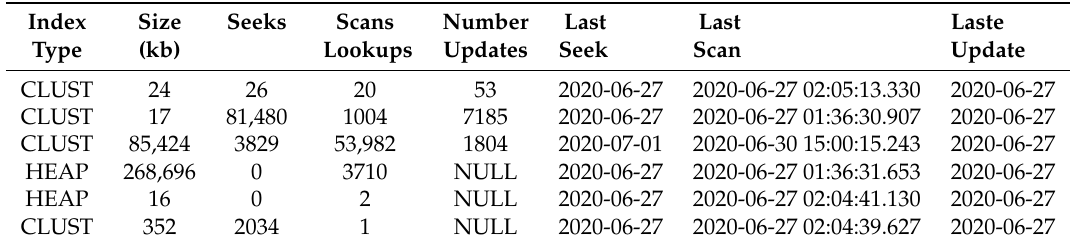
Table 1. Index statistics of the DBMS. These data are used as the neural network training dataset.